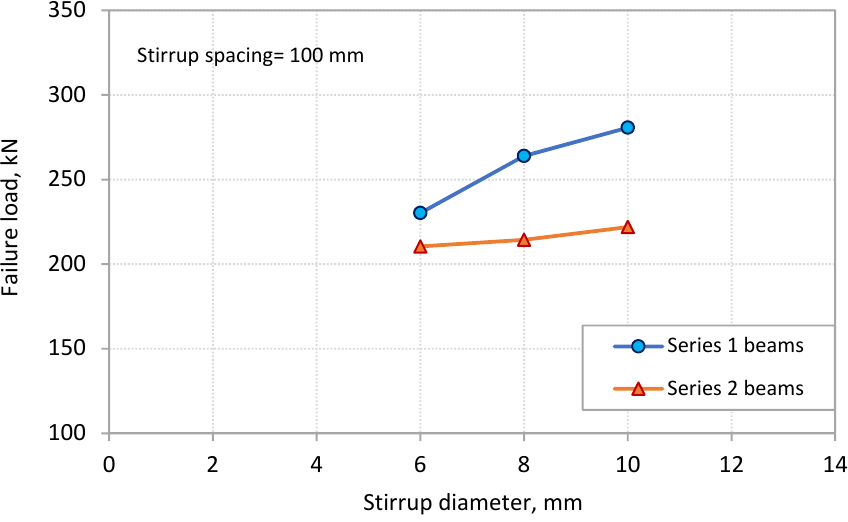
Figure 7. Effect of stirrup diameter on PE debonding capacity.